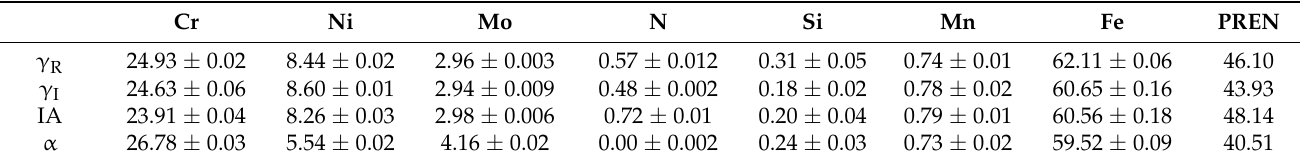
Table 1. Element contents of γ R , γ I , IA and α (mass. %).